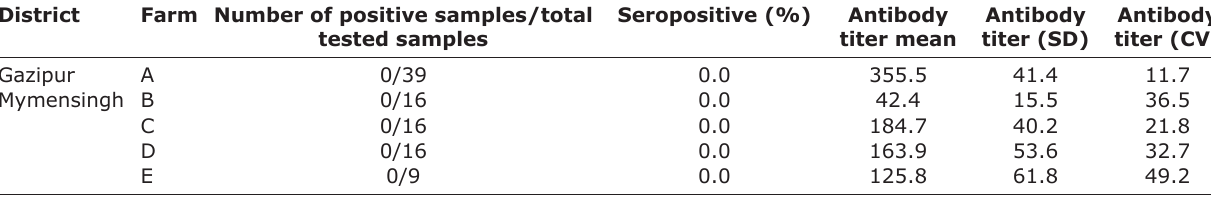
Table-4: Serological detection of ARV in layer according to farm. District